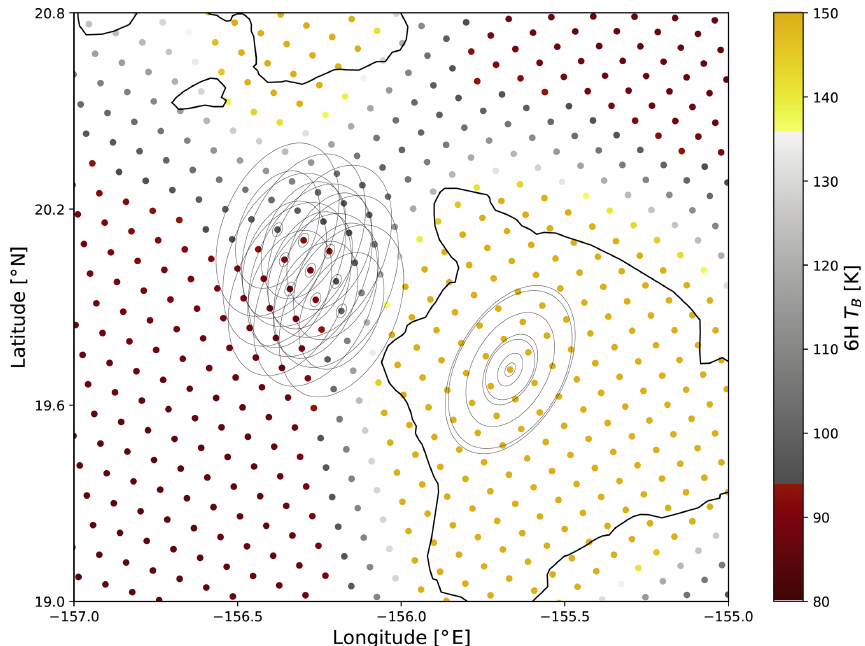
Figure 1. An example of FOV sizes and measured T B at the 6H channel near the island of Hawai‘i, from an AMSR2 orbit on 21 Septem- ber 2016. The T B s at 6H are shown in coloured dots, with the HPBW given at all AMSR2 frequencies for one observation centre viewing the island itself. The HPBW is outlined for three frequencies only (6, 10, 89GHz), for three consecutive observation centres along- and across-scan just west of the island, so as to view the spatial overlap without too much